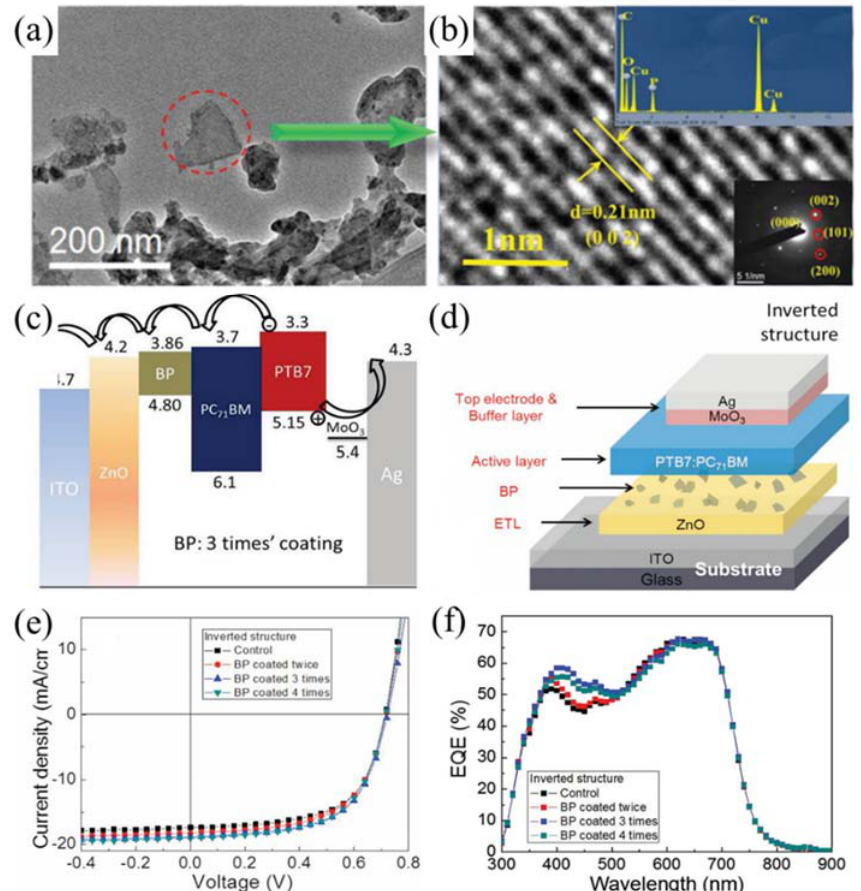
Figure 8. ( a ) TEM image of drop-casted BP flakes; ( b ) HRTEM image of the BP flake, the insets are SAED pattern ( top ) and EDX result ( bottom ); ( c ) Energy band structure of the OSCs with the incorporation of BP; ( d ) Inverted architectures of OSCs based on PTB7/PC 71 BM.; ( e ) J-V characteristics of inverted OSCs; ( f ) EQE characteristics of a control device and the inverted OSCs. Reprinted with permission form [93]. Copyright 2016 John Wiley and Sons.